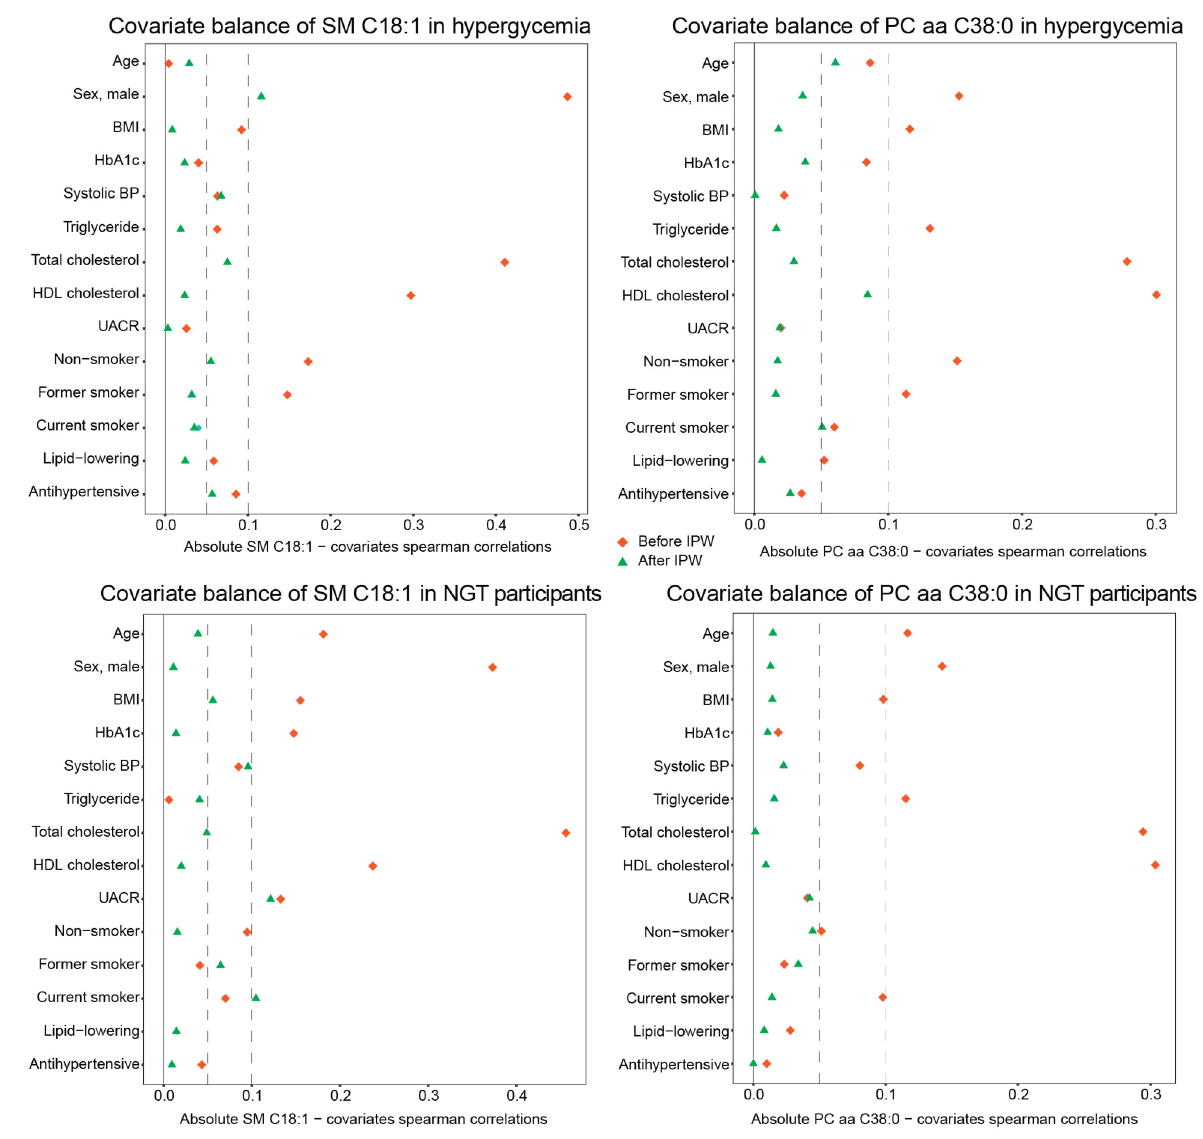
Figure 5. Inverse probability weighting improves metabolite–covariate balance. The absolute values of Spearman’s correlation coefficients for SM C18:1 or PC aa C38:0 with various covariates before and after IPW in hyperglycemic and NGT individuals of KORA FF4 are shown. The interrupted lines represent 0.05 ( left ) and 0.1 ( right ) absolute value of Spearman’s correlation coefficients. Abbreviations: IPW, inverse probability weighting; SM, sphingomyelin; PC aa, phosphatidylcholine diacyl; NGT, normal glucose tolerance. HbA 1C , glycated hemoglobin; BP, blood pressure; UACR, urinary albumin-to-creatinine ratio.